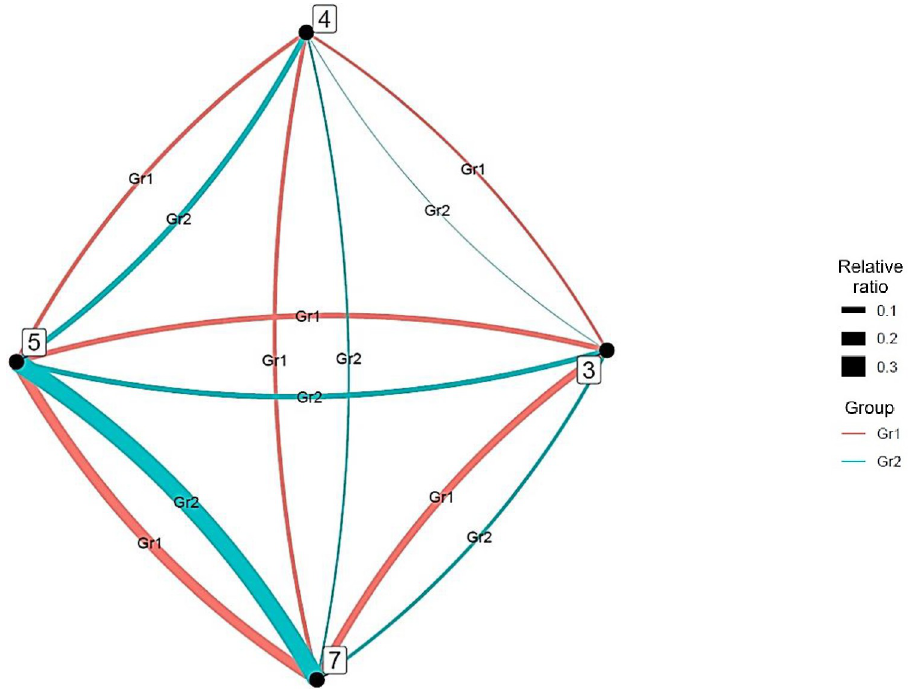
Fig 17. Distinctive interdisciplinary links of each internet of things